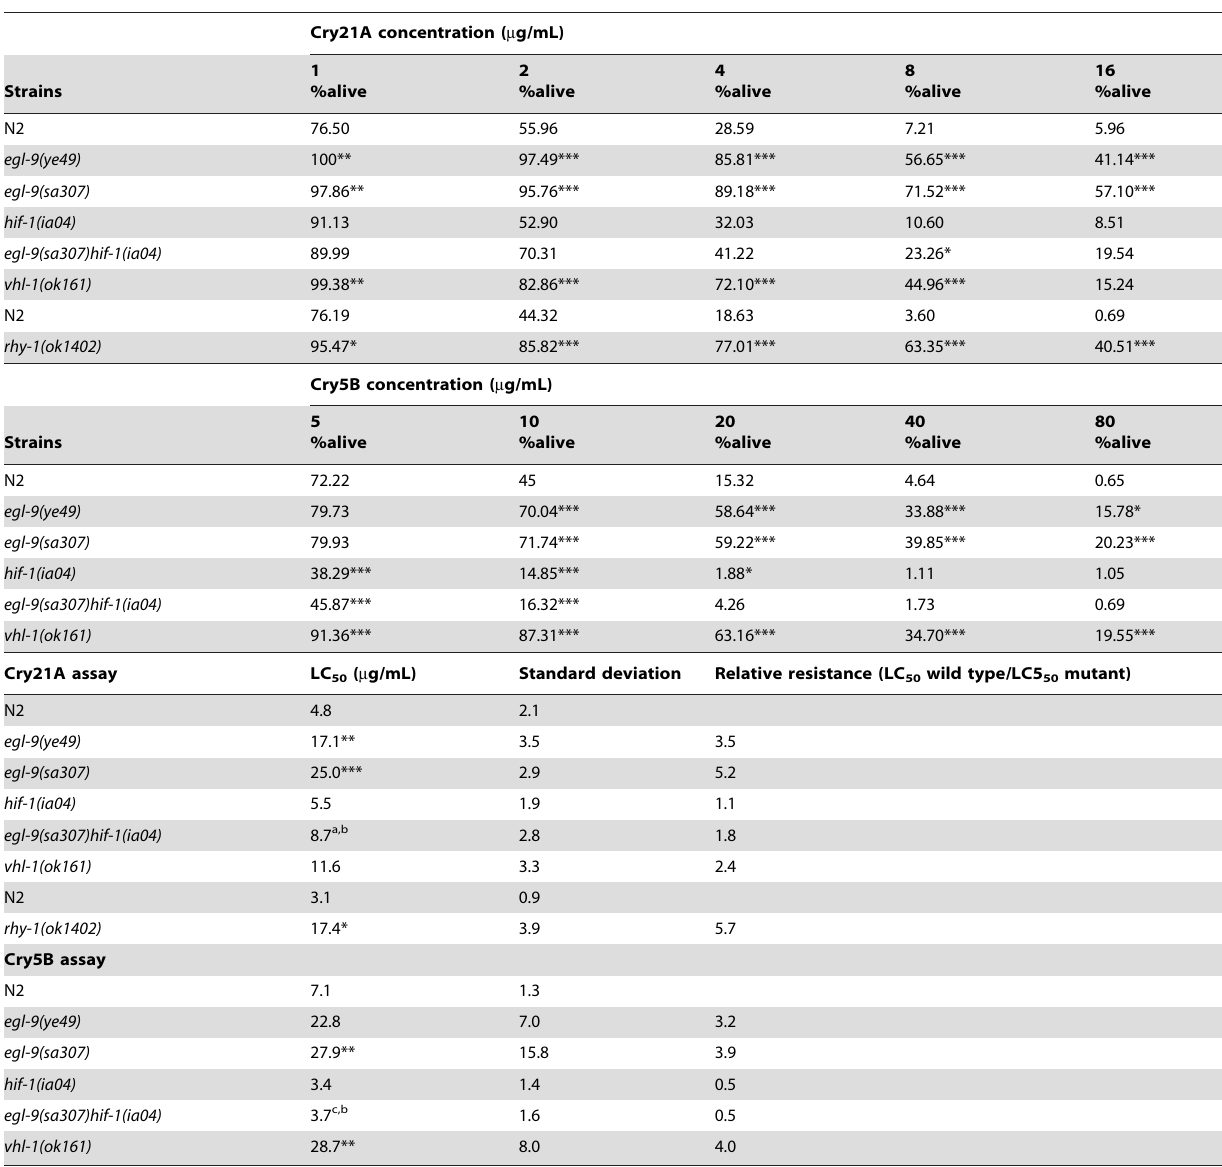
Table 1. Data and analyses for Cry21A and Cry5B dose-dependent mortality assays.